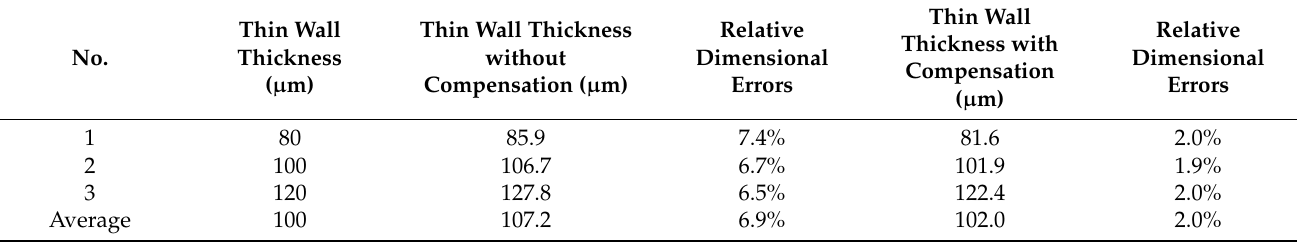
Table 7. Comparison of relative dimensional